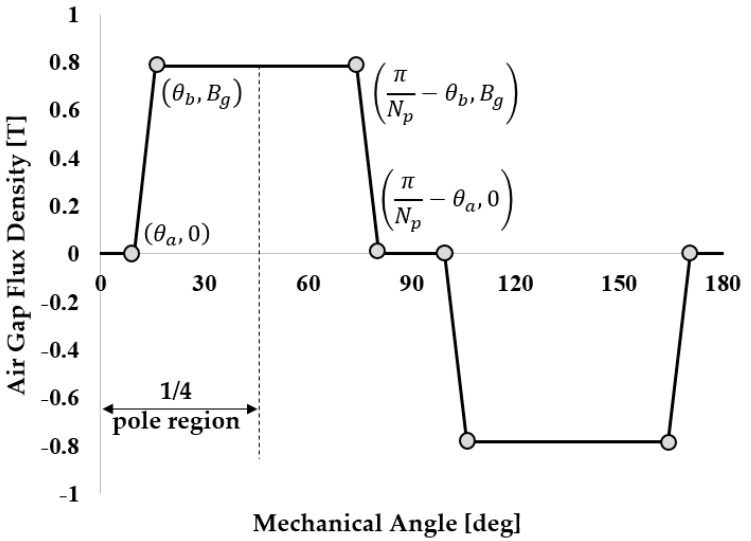
Figure 2. The slotless air gap flux density distribution.